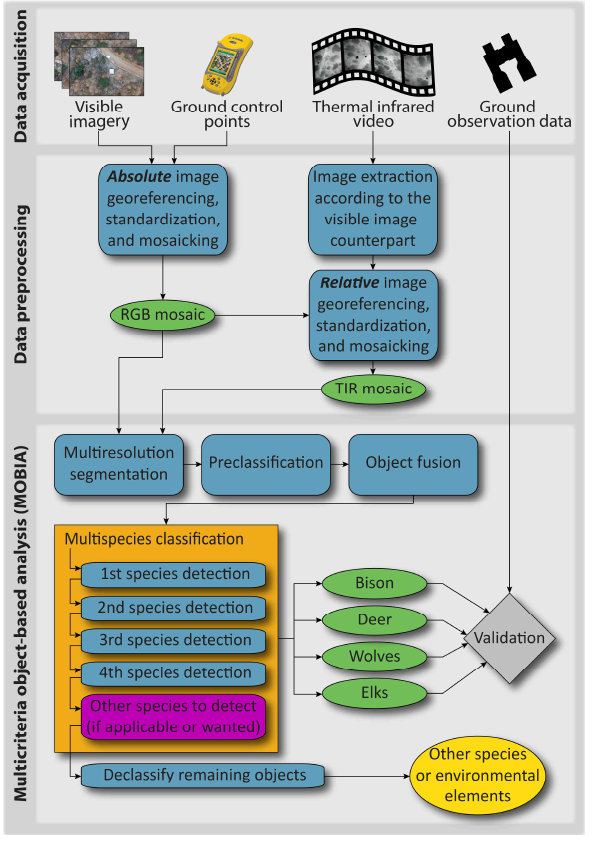
Figure 4. Multispecies detection including data acquisition, preprocessing, and multicriteria object-based image analysis